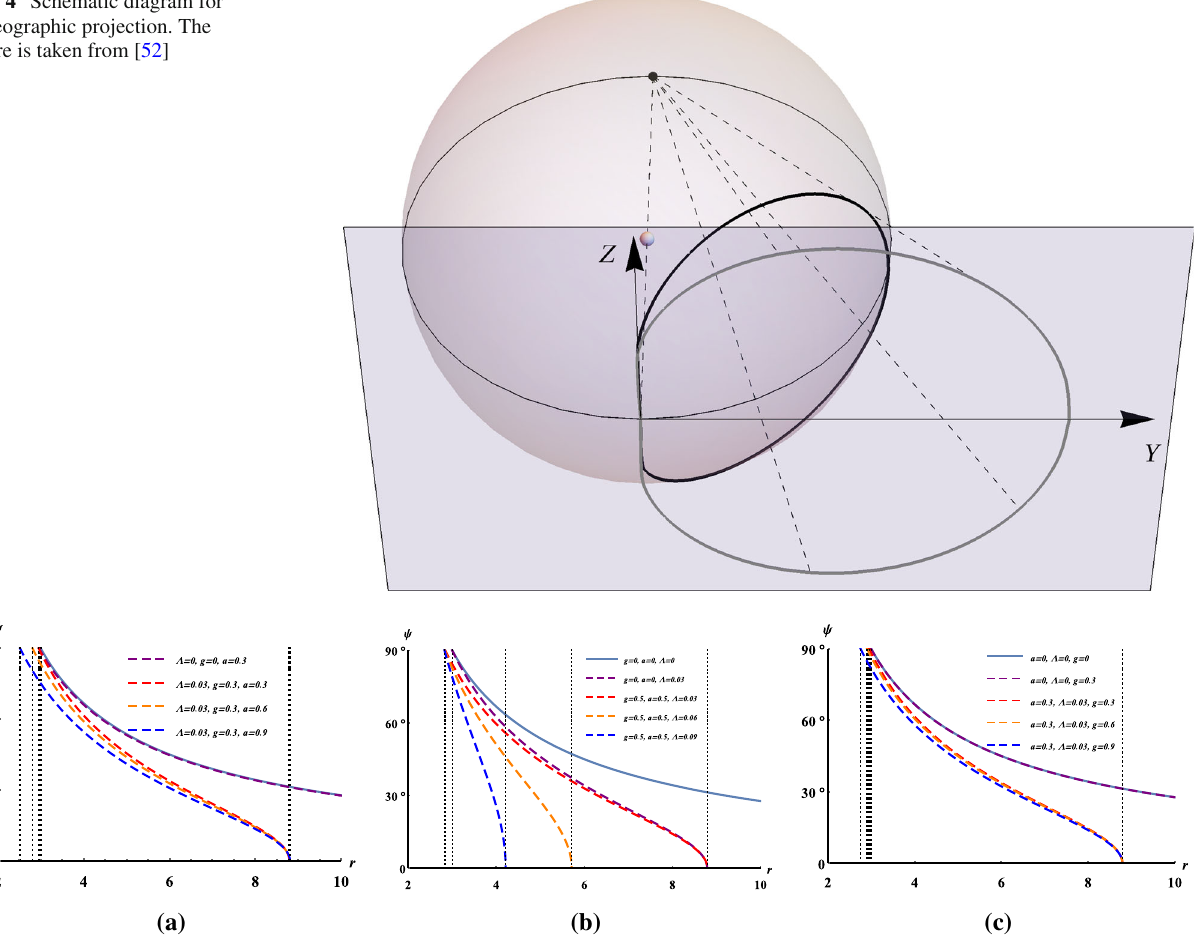
Fig. 4 Schematic diagram for